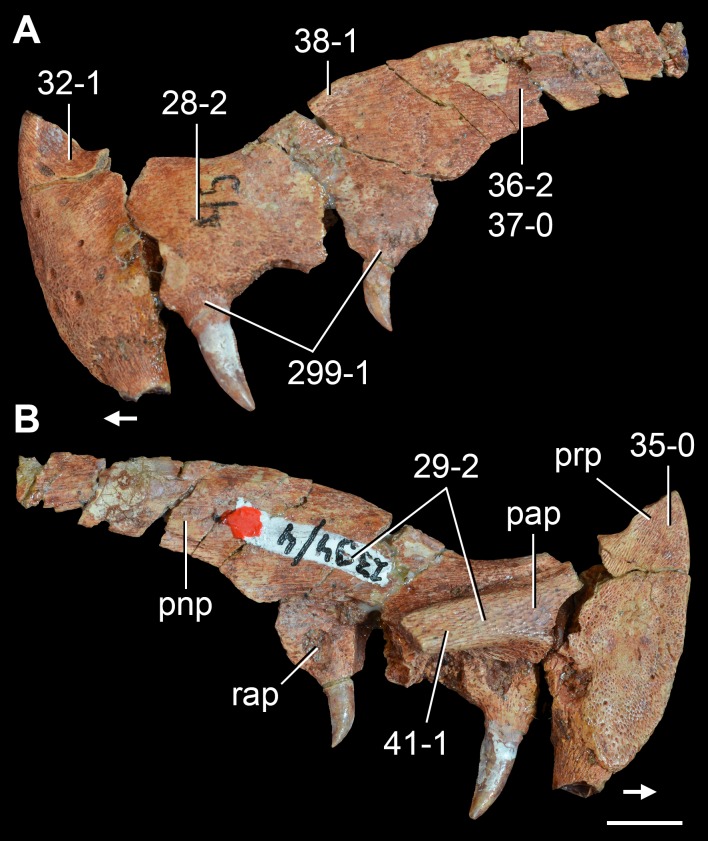
“Chasmatosuchus” vjushkovi.Holotype partial left premaxilla (PIN 2394/4) in (A) lateral and (B) medial views. Numbers indicate character-states scored in the data matrix and the arrows indicate anterior direction. Abbreviations: pap, palatal process; pnp, postnarial process; prp, prenarial process; rap, reabsorption pit. Scale bar equals 5 mm.